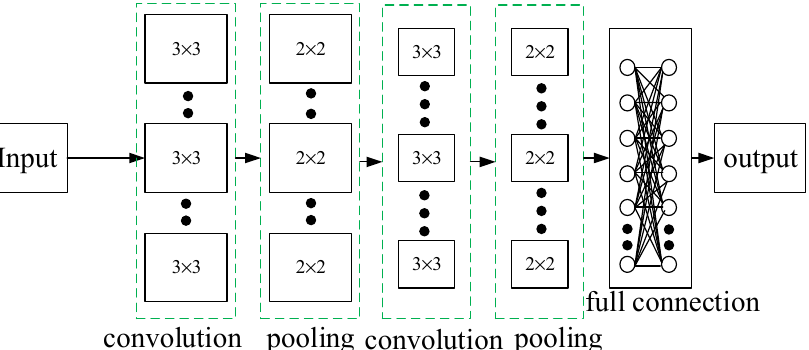
Figure 1. Typical CNN architecture.